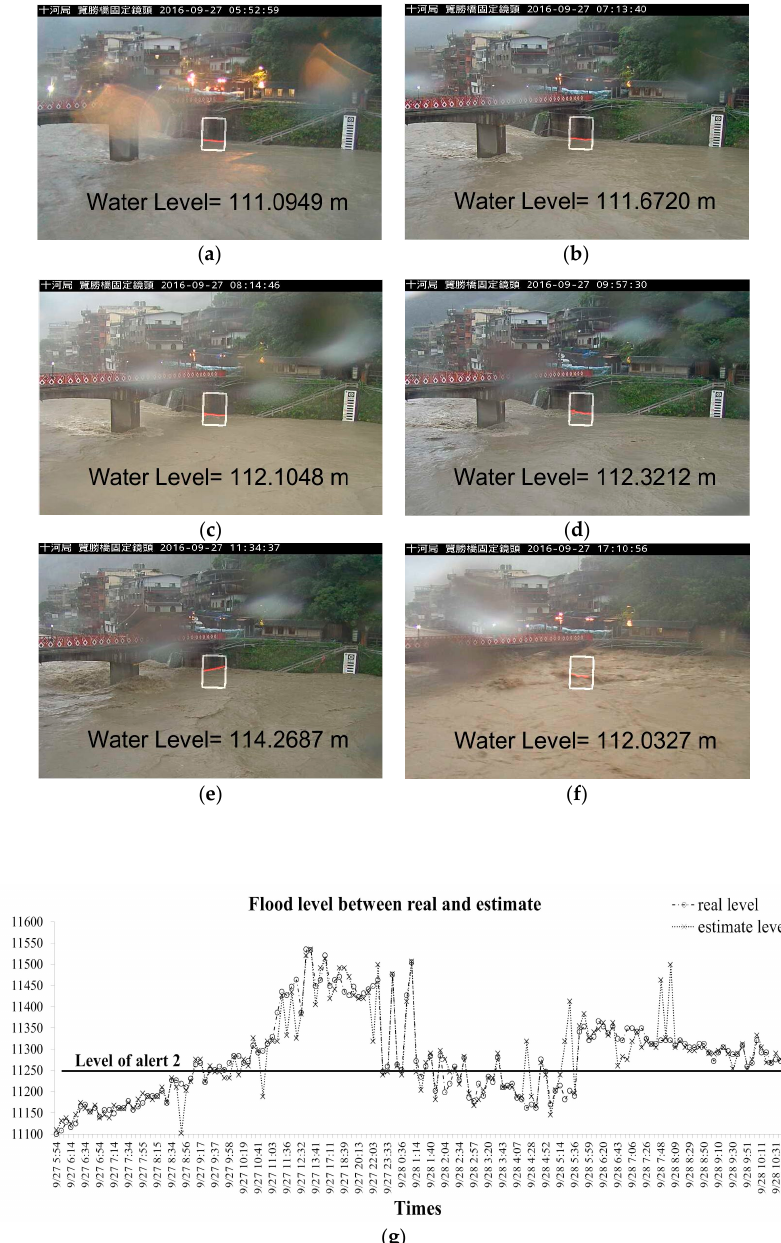
Figure 9. Real-time image water level monitoring and analysis. ( a – f ) The monitoring course of typhoon Megi. The white box represents the region for analysis. The white line in the box represents the estimated water level. In the ( f ) panel, it is obvious that the flood water level exceeds the analyzing region; hence, the water level could not be correctly identified. ( g ) The progress of the water level analysis of a monitoring cycle. Real line was shown for the level of